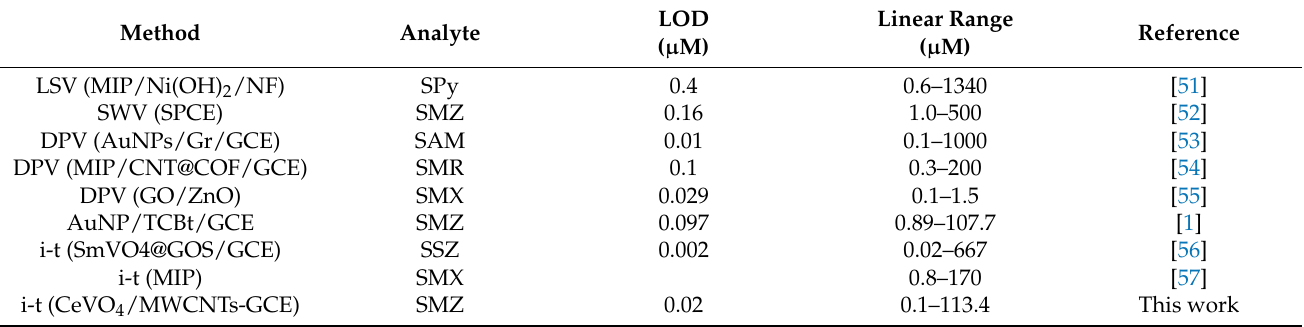
Table 1. Comparison of analytical performance between literature works end this